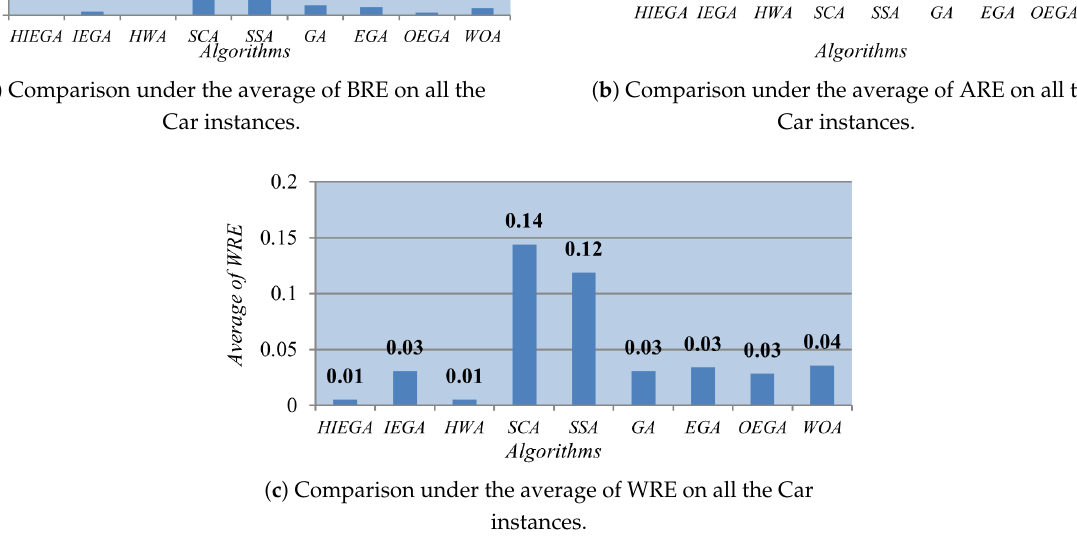
Figure 4. Comparison among algorithms on the car instances.